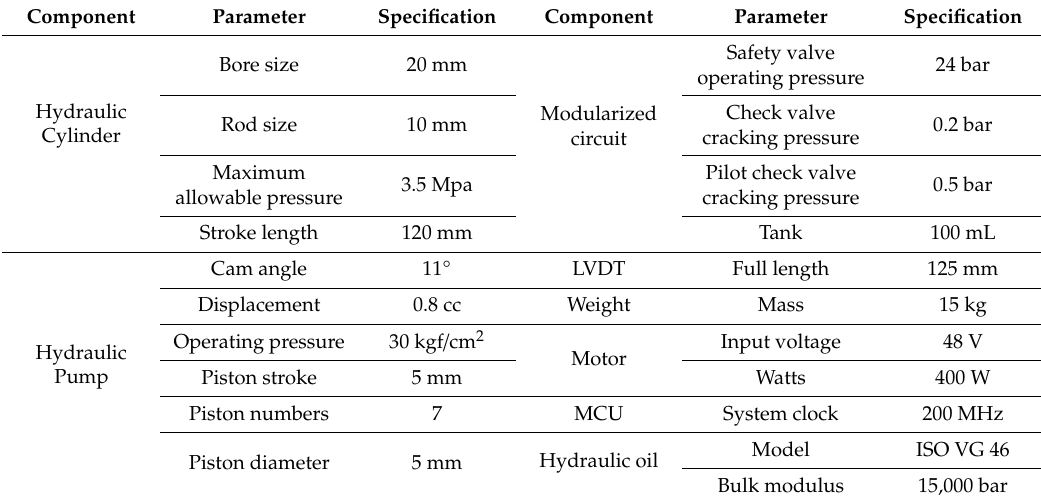
Table 2. Hydraulic Parameters for the electro-hydraulic actuator (EHA)